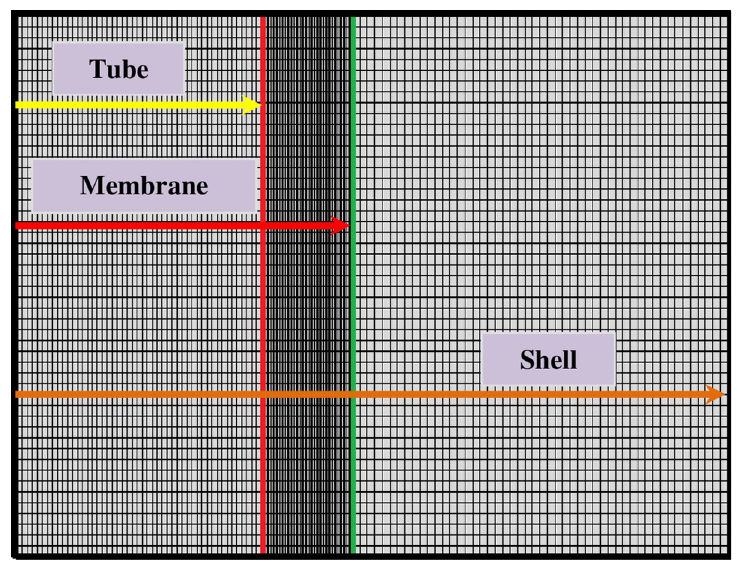
Fig 2. Employed mapped meshes in all domains of the PMC.